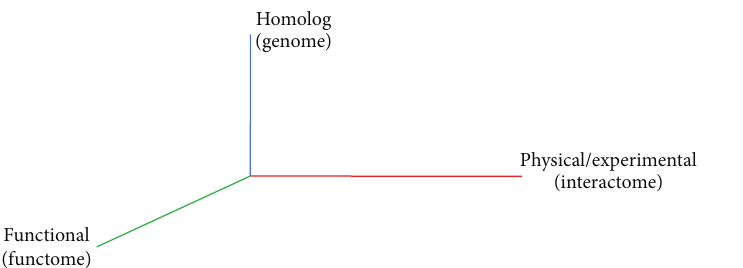
Figure 2: 3D alignment guided by physical interaction (interactome), sequence similarity (genome), and functional coherence (functome) of proteins in the network.